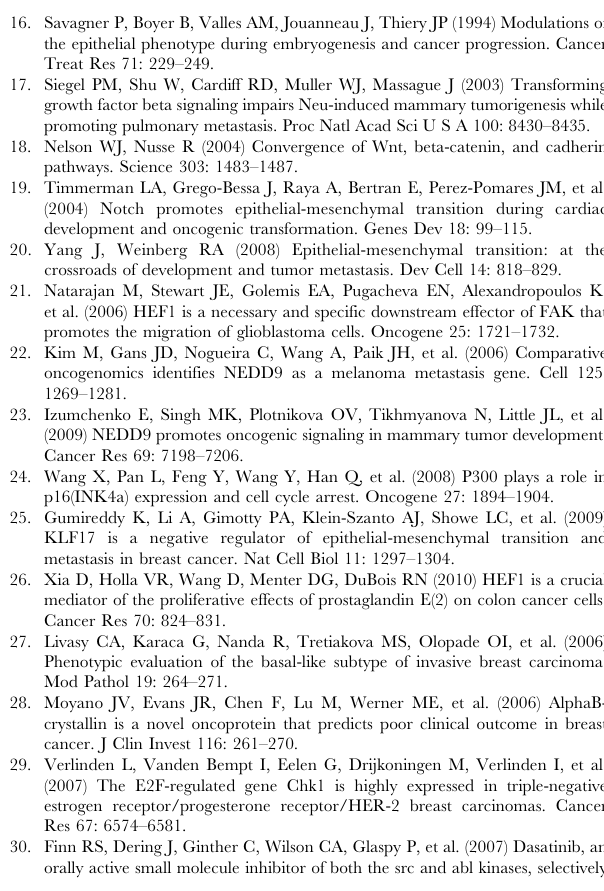
Figure S1 NEDD9 knock down inhibited tumor cell migration and invasion. trans-well migration and invasion assays in NEDD9 siRNA-MDA-MB-231 cells with or without 12 m M mitomycin C (MMC). Figure S2 Suppression of NEDD9 expression inhibited tumor cell migration and invasion. Migration and invasion assays upon NEDD9 knockdown in HCC1937 cells. The migration and invasion ability is presented as fold changes in number of cells migrated to the bottom chamber. Each bar represents the mean SEM of samples measured in triplicate, and each experiment was repeated at least three times. Figure S3 NEDD9 increased the expression and secre- tion of MMP-9. A, Identification of the gelatinolytic enzymes produced by NEDD9-MCF10A and control cells. The condi- tioned media and the cellular extracts were collected, centrifuged and the proteins were analyzed by zymography in gelatin- embedded SDS polyacrylamide gels. B, Western analysis showing